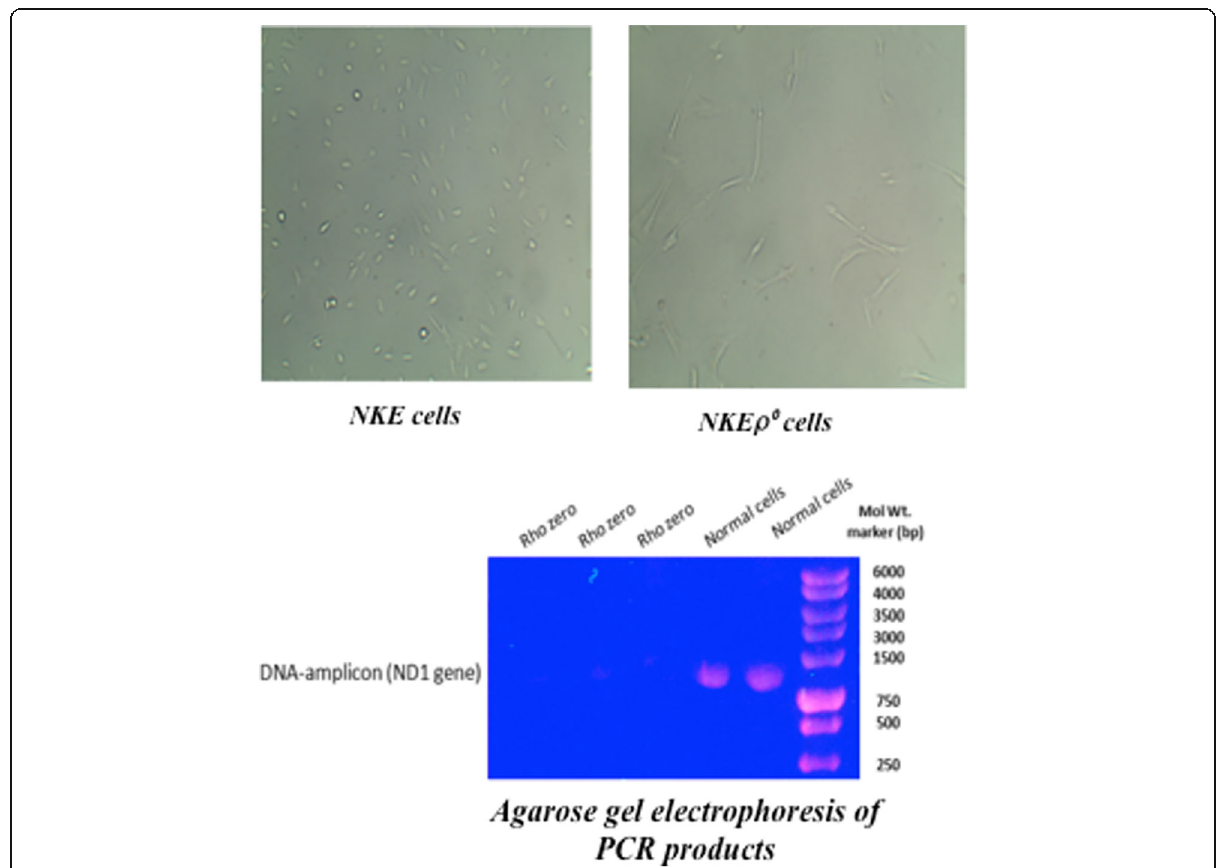
Fig. 6 Development of ρ ° cells from NKE cells. NKE ρ ° cells were generated from NKE cells by selectively depleting mitochondrial DNA using ethidium bromide as described in materials and methods. Mitochondrial DNA was isolated from NKE and ρ ° cells, and ND1 gene amplicon from mitochondrial DNA (as amplified using PCR) was checked using agarose gel